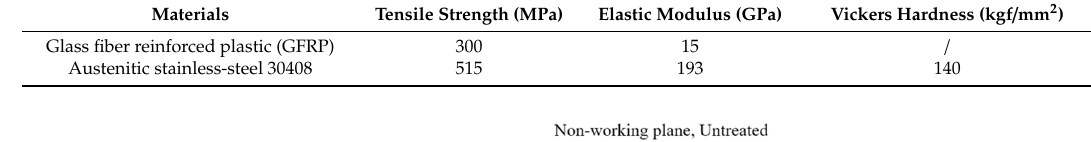
Table 1. Mechanical properties of plates.